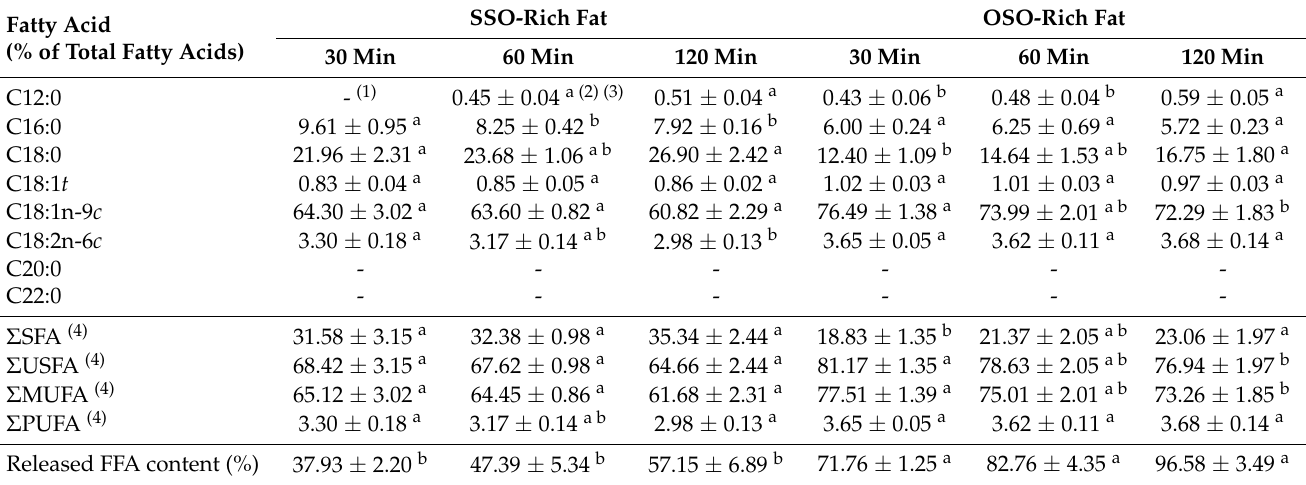
Figure 6. Free fatty acids released (%) of the SSO-rich and OSO-rich fats during in vitro multi-step digestion model (30, 60, 120 min). * Means on the bars in each digestion time are significantly different by Student’s t -test at p < 0.05. Mean ± SD ( n = 2). Table 5. The released fatty acids composition of the hydrolyzed SSO-rich and OSO-rich fats during in vitro multi-step